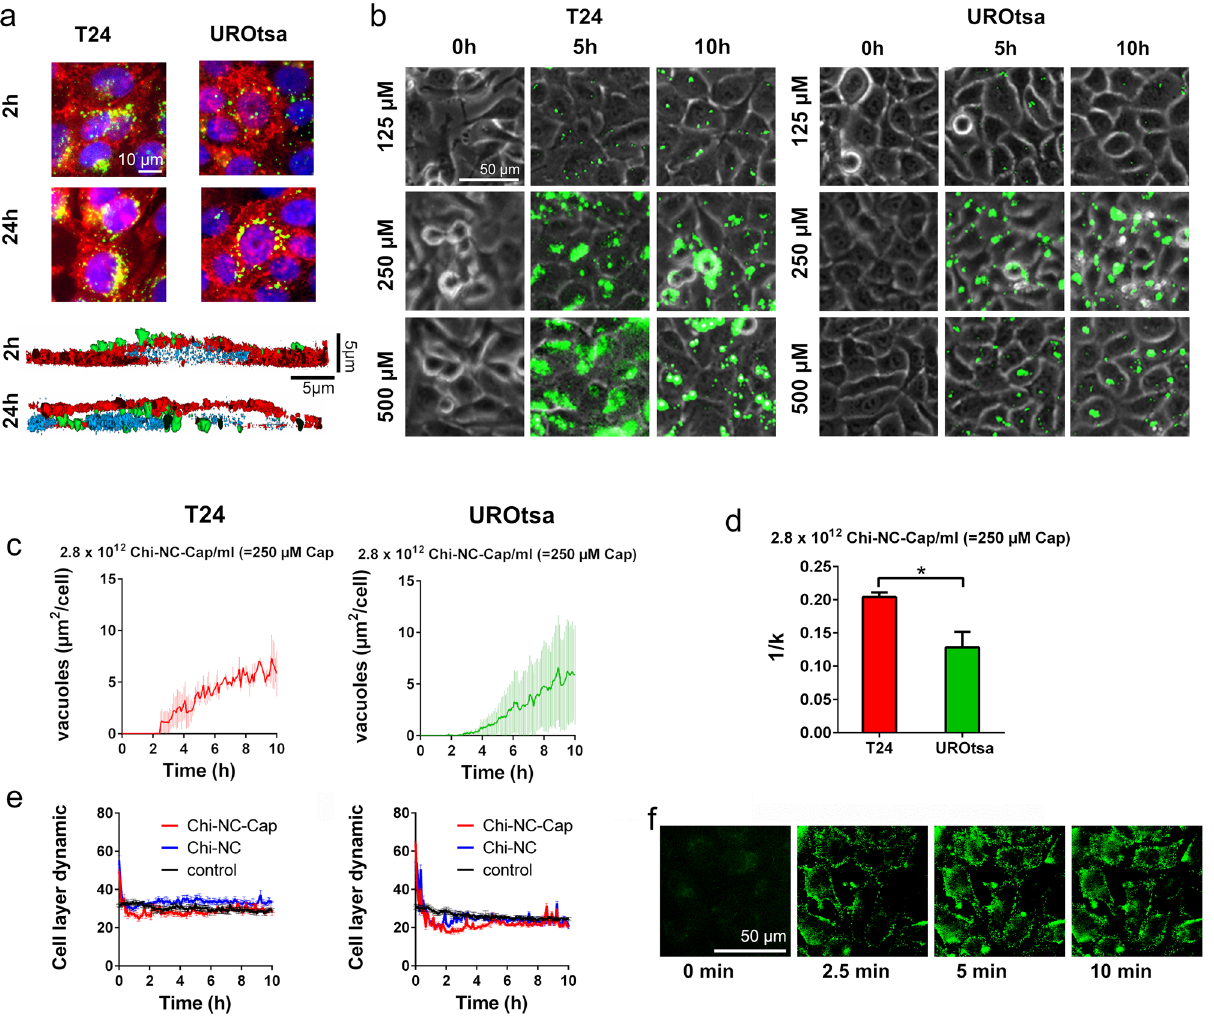
Figure 4. Influence of encapsulated capsaicin on T24 and UROtsa cells. ( a ) Internalisation of fluorescent Chi- NCs (green) into T24 or UROtsa cells was measured by structured illumination microscopy. Nuclei are stained with 4 ′ ,6-diamidino-2-phenylindole (blue), cell surfaces (red) were stained with WGA. The upper panel shows two-dimensional images of cells treated for 2 or 24 h with Chi-NCs (2.8 × 10 12 particles mL −1 ). Scale bar = 50 µm. The lower panel shows a lateral cross-section of UROtsa cells which has been reconstructed from three- dimensional image stacks. Scale bars = 5 µm. After 2 h of incubation, Chi-NCs are mainly at the cellular surface; after 24 h of incubation, Chi-NCs are underneath the cell surface close to the nucleus ( b ) Snapshots of live cell fluorescence microscopy images of UROtsa and T24 cells treated with different concentrations of capsaicin- loaded Chi-NCs (1.4 × 10 12 particles mL −1 = 125 µm capsaicin, 2.8 × 10 12 particles mL −1 = 250 µm capsaicin, and 5.6 × 10 12 particles mL −1 = 500 µm capsaicin) at different points in time (0 h, 5 h and 10 h). Scale bar = 50 µm. ( c ) Quantitative analysis of vacuole formation. Vacuole area is normalized to the number of treated cells. Data are presented as mean ± SD ( n = 3). ( d ) Quantitative analysis of the ability of the cells to deposit capsaicin in vacuoles ( k − 1 ). Data are presented as mean ± SD ( n = 3, * p < 0.05). ( e ) Analysis of cell layer dynamics of T24 (left) and UROtsa cells (right) either treated with RPMI-1640 medium (control) or treated with capsaicin-loaded Chi-NCs (= Chi-NC-Cap) at a concentration of 500 µm capsaicin (5.6 × 10 12 particles mL −1 ) and with Chi-NCs without capsaicin (5.6 × 10 12 particles mL −1 ). Data are presented as mean ± SD ( n = 3). ( f ) Snapshots of live cell fluorescence microscopy images of T24 cells, 0, 2.5, 5 and 10 min after treatment with DiO-loaded Chi-NCs (5.6 × 10 12 particles mL −1 ) indicating the rapid binding of Chi-NCs to the cell surfaces. Scale bar = 50